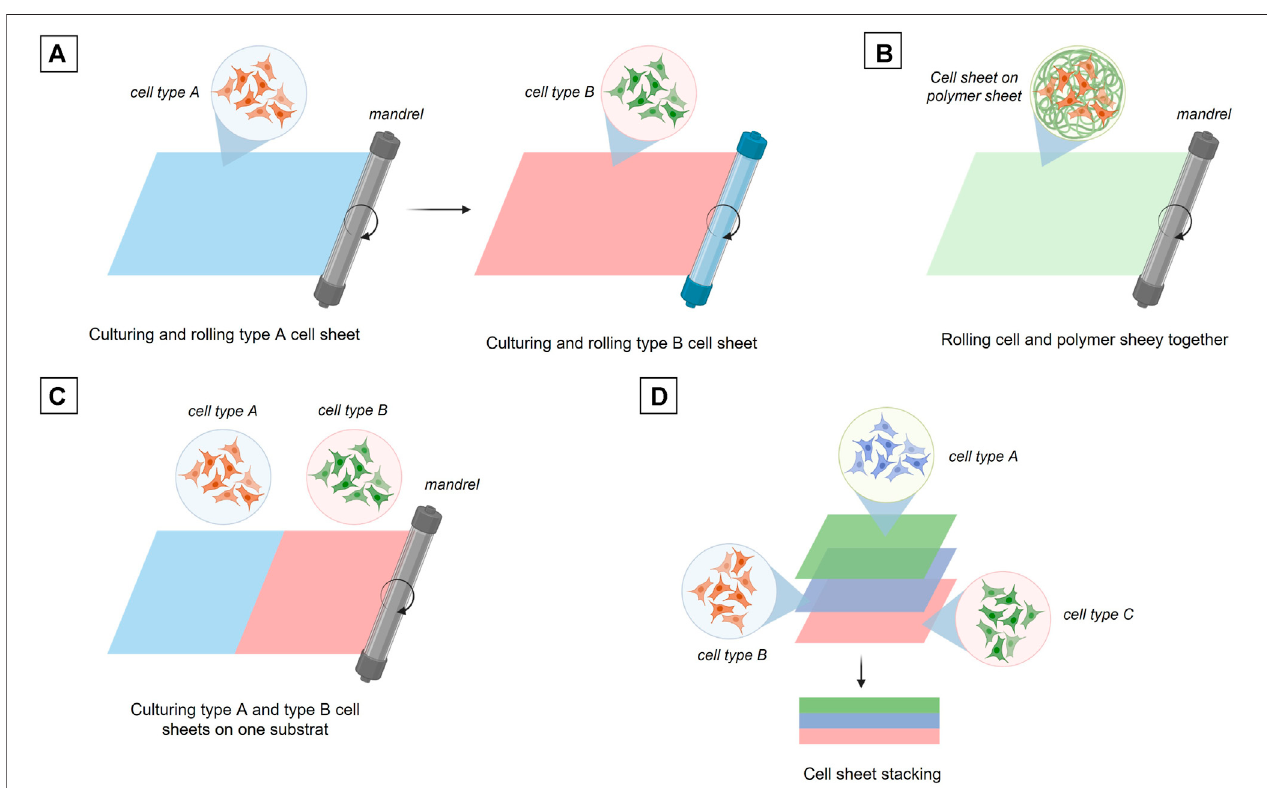
FIGURE6| Fabrication oftissue engineeredblood vessel through cellsheetengineering. (A) Sequential rollingofdifferentcell type sheets. (B) Rollingofaculturing cell sheet onto a polymer sheet. (C) Rolling two different cell types culturing on the same substrat. (D) Three cell sheets stacking.